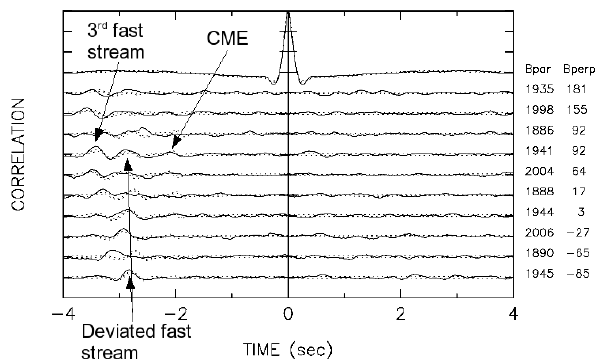
Fig. 4. Diagram demonstrating the geometry of the new model in- cluding two fast streams. The line of sight is displayed as though it were mapped back down to the corona, with the corona displayed in the form of a Carrington map. Hence the horizontal axis represents heliographic longitude and the vertical axis represents heliographic latitude with the equator across the centre. It should be noted that each stream may have a variable width, including zero.